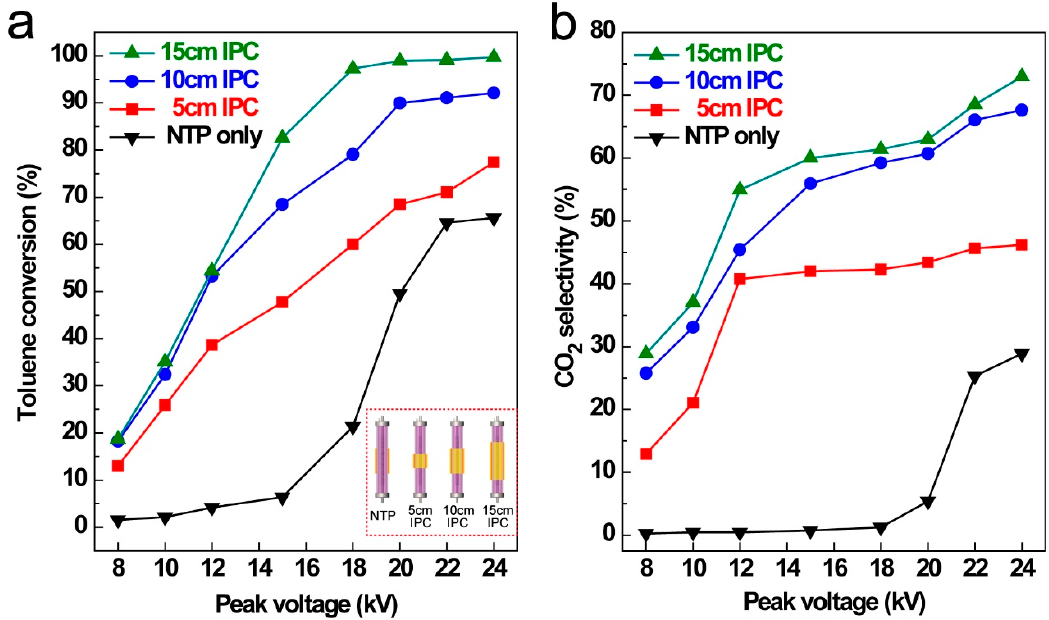
Figure 4. Toluene conversion ( a ) and CO 2 selectivity ( b ) with various catalyst loadings and absence of catalyst as a function of applied peak voltage. (reaction condition: toluene initial concentration = 1000 ppm, flux = 400 mL/min, RH = 0%, ambient temperature = 25 °C).